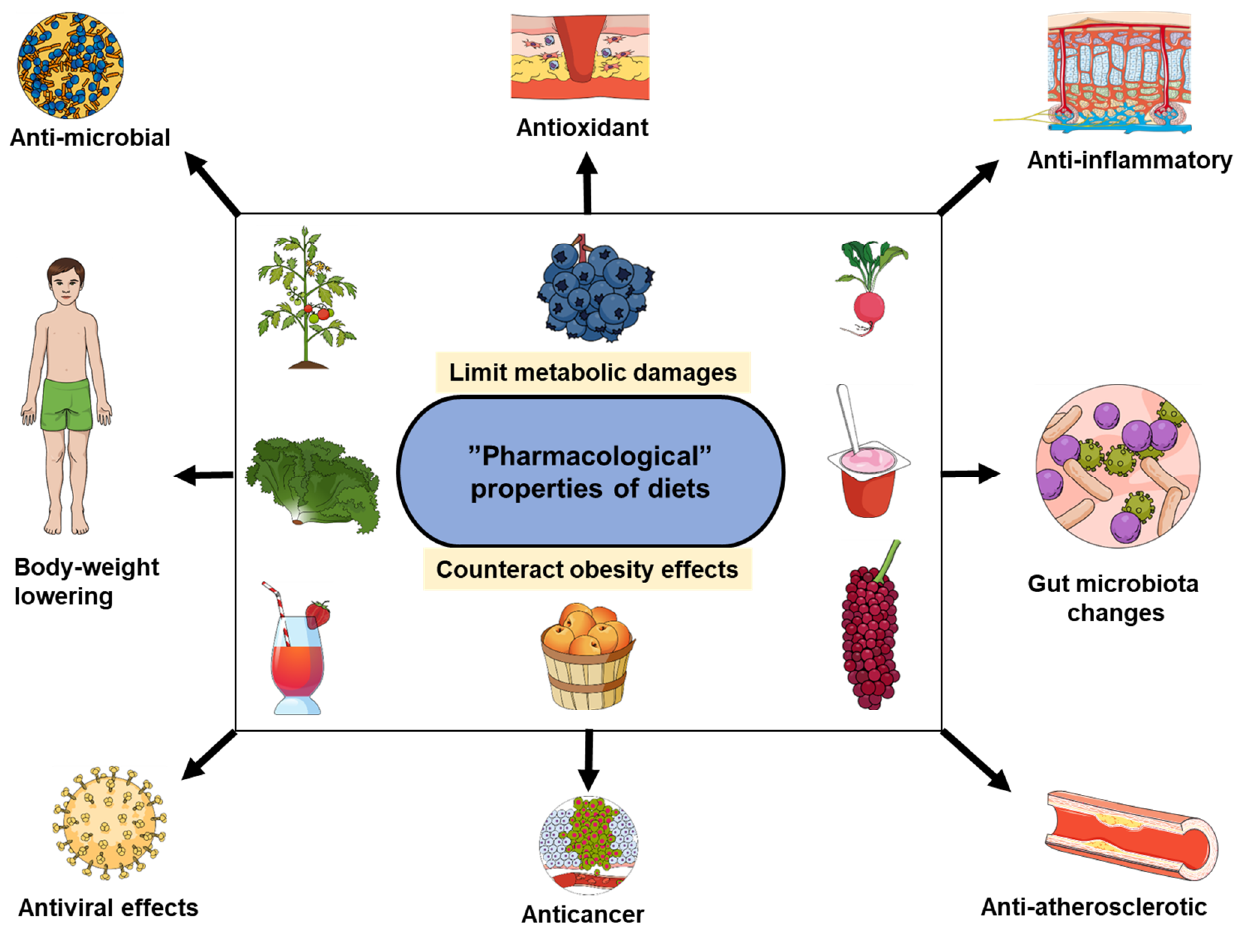
Figure 1. The energy balance-independent diet benefits are close to pharmacological effects. The diverse benefits related to food include properties that counteract consequences of obesity, such as inflammation, cancer risk and metabolic dam- ages.